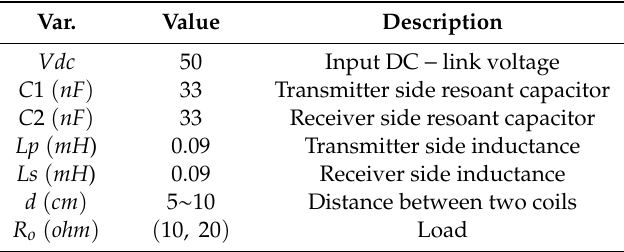
Figure 14. Flow chart of frequency-tracking algorithm. Table 1. Specifications of the WPT system.